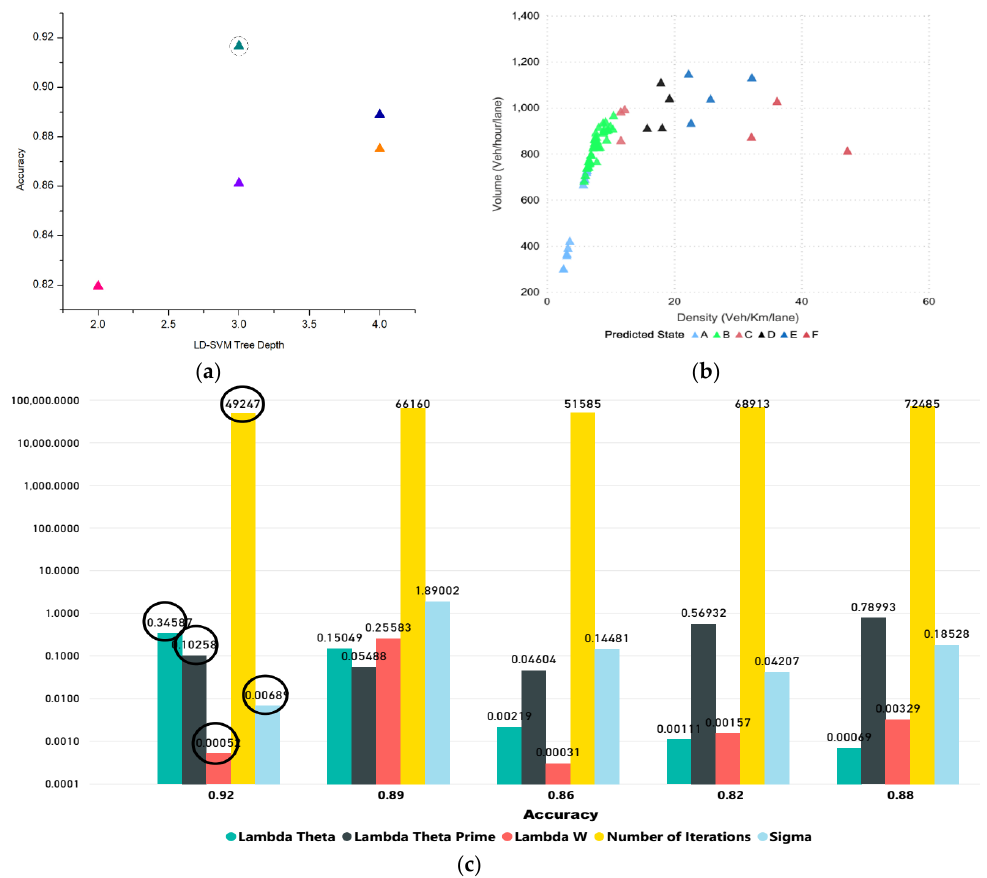
Figure 8. The LD-SVM model. ( a ) The impact of tree depth on accuracy. ( b ) Predicted state for next 15 min. ( c ) Impact of Lambda theta, Lambda theta prime, Lambda W, and sigmoid function on accuracy.